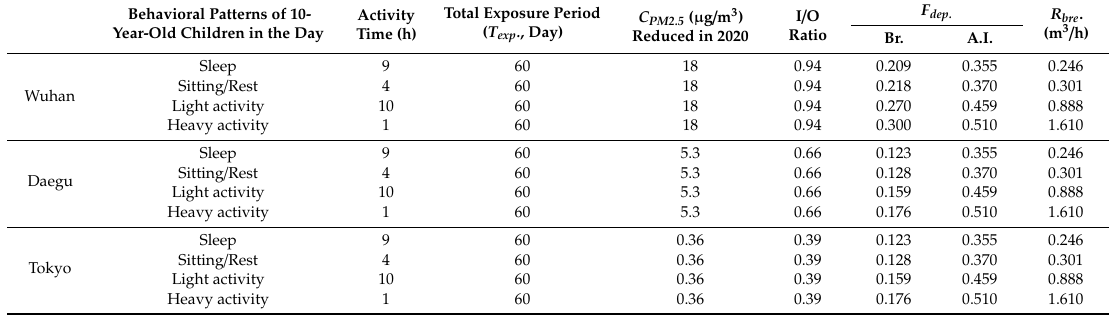
Table 1. The variables for calculation of the reduced Dose PM 2.5 ( µ g) for the 10-year-old children per day and over two months after the self-reflection of each city.